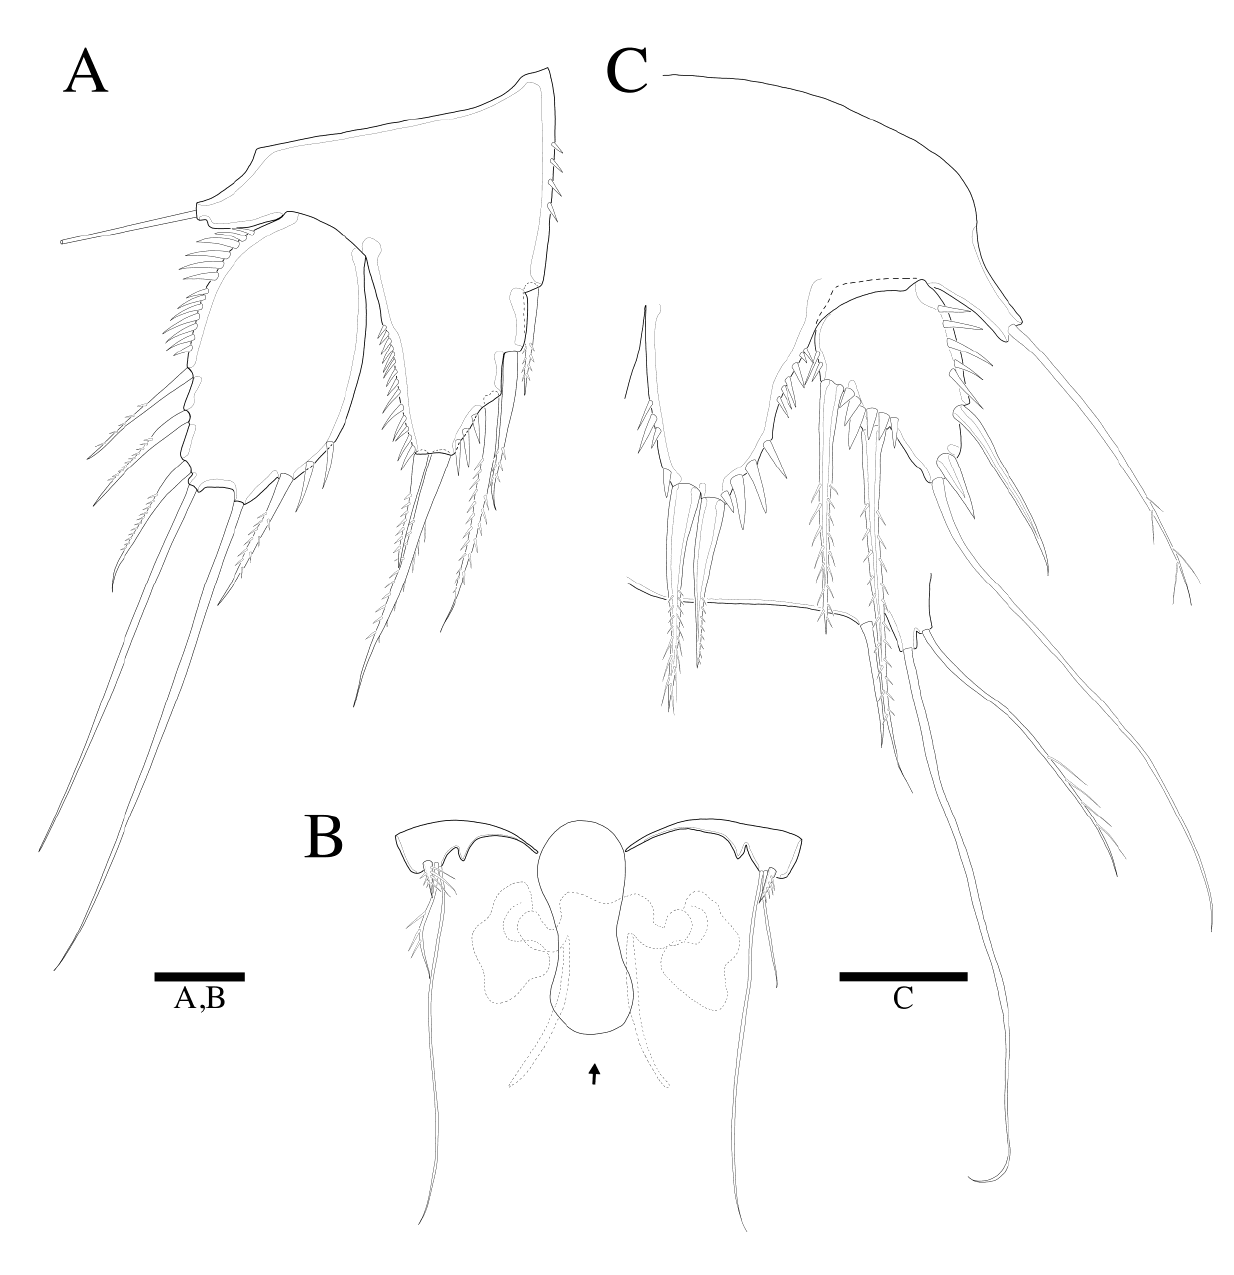
Figure 7. Robertgurneya jejuensis sp. nov. Female. ( A ) P5. ( B ) Genital field and P6 (arrow: epicopula- tory bulb). Male. ( C ) P5 and P6. Scale bars: 20 µ